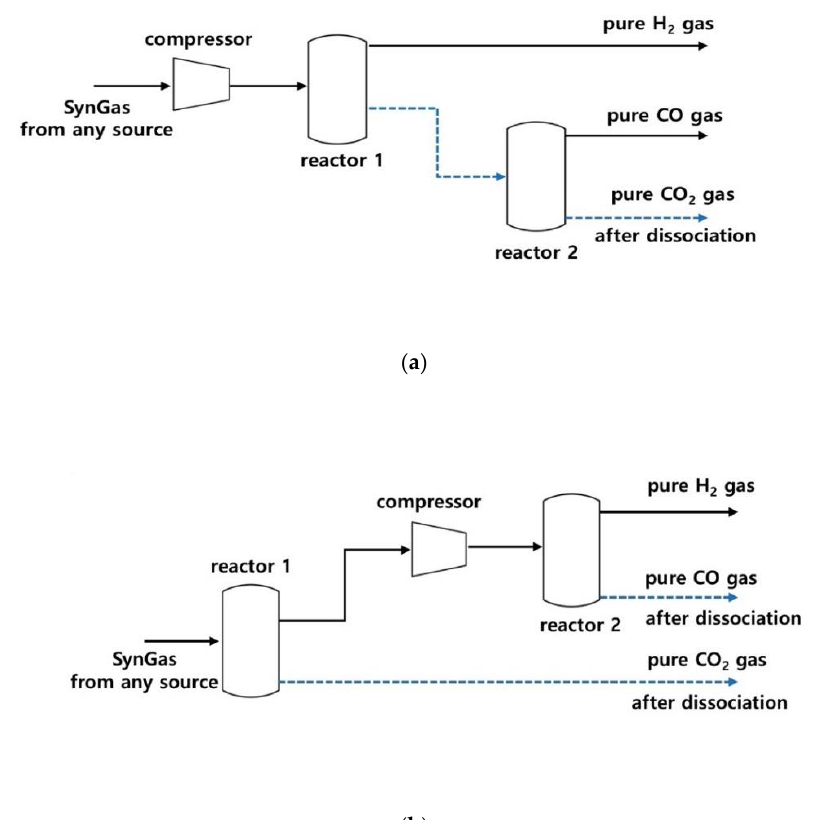
Figure 6. Two conceptual clathrate-based processes for CO 2 separation of synthesis gases from a variety of sources: ( a ) A clathrate-based process for separating H 2 from the first reactor, then separating CO 2 at the second reactor; ( b ) In this process, CO 2 is separated first, then the remaining gas mixture is compressed and reacted to separate CO in the clathrate form from gaseous H 2 . Dotted blue lines indicate the flow of the solid clathrate compounds in the process. By recycling empty (guest-free) or degassed hydroquinone clathrates after dissociation to remove enclathrated gases, the processing time might be shortened.